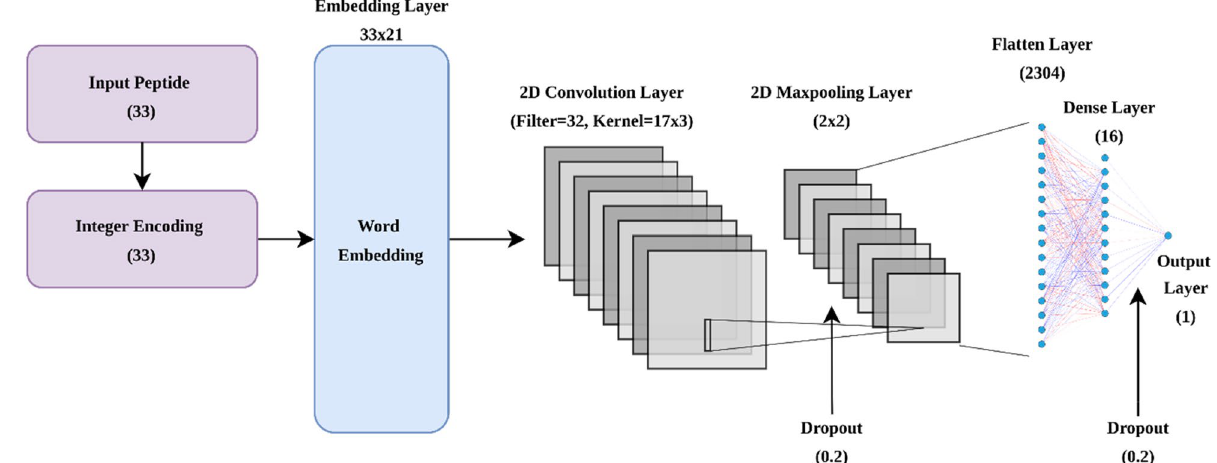
Figure 1. Architecture of supervised word embedding based model using a convolutional neural